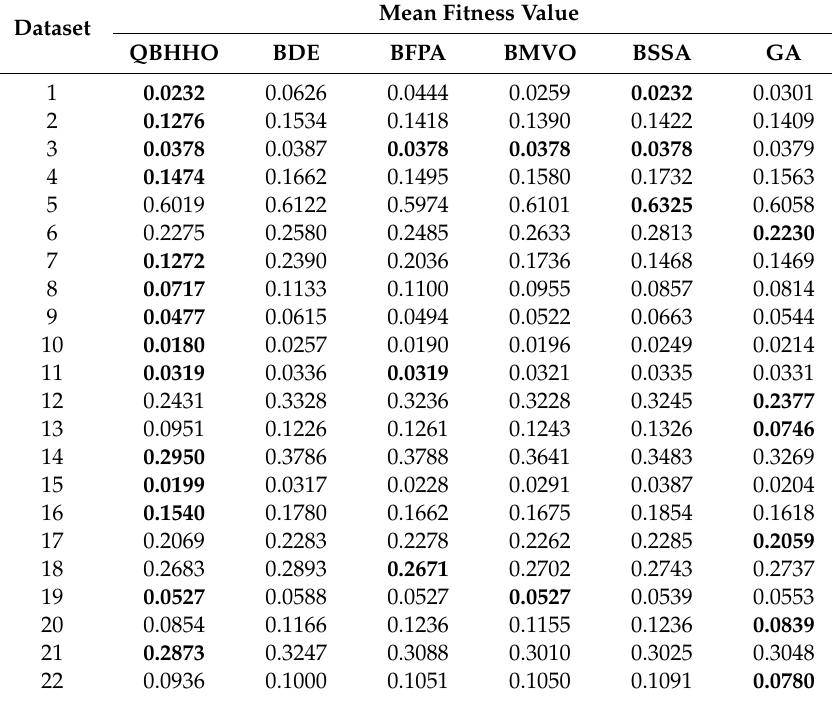
Table 11. Experimental result of the mean fitness value of six di ff erent